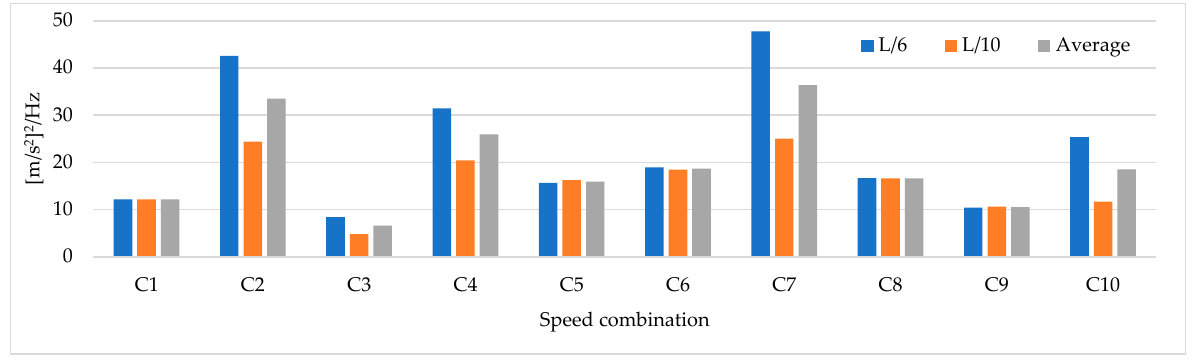
Figure 10. Percentage of relative frequency error for different speed combinations (L/6 and L/10).